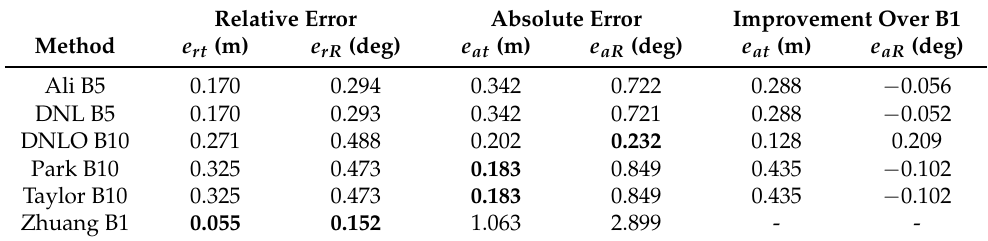
Table 1. Camera to lidar calibration on KITTI 2011_09_30_drive_0027 . Relative Error Absolute Error Improvement Over B1